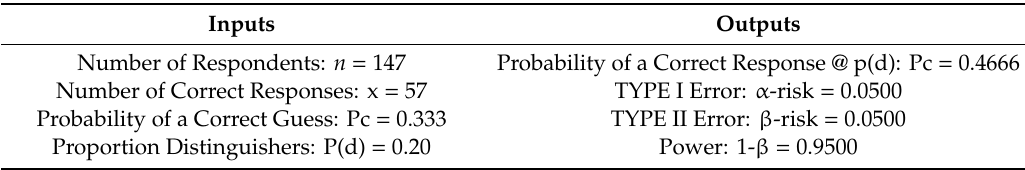
Table 3. Sensory analysis inputs and